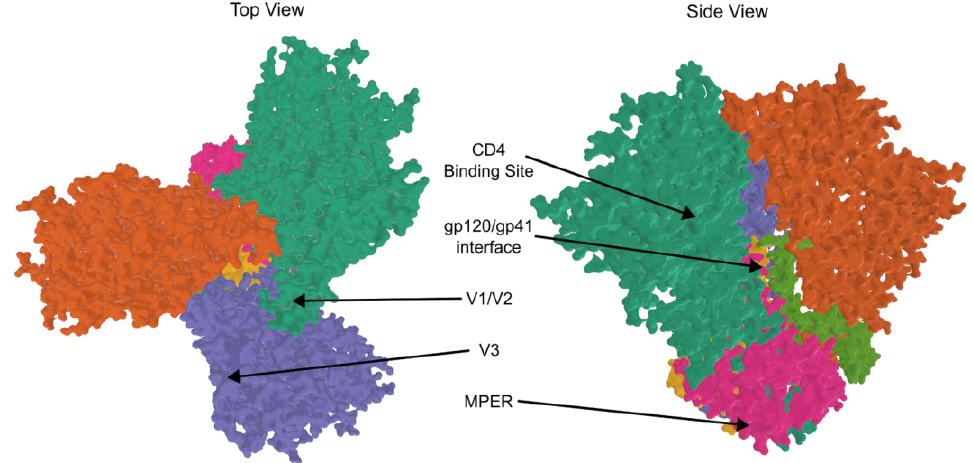
Figure 3. bNAb binding sites. Individual monomers are shown in orange, green, and purple and form the trimeric gp120. Yellow, pink, and neon green depict monomers within the trimeric gp41. The bNAb binding sites are indicated with arrows: the CD4 binding site, gp120/gp41 interface, V1/V2, V3, and MPER. Drawn from PDB ID: 6VRW [43 – 47].